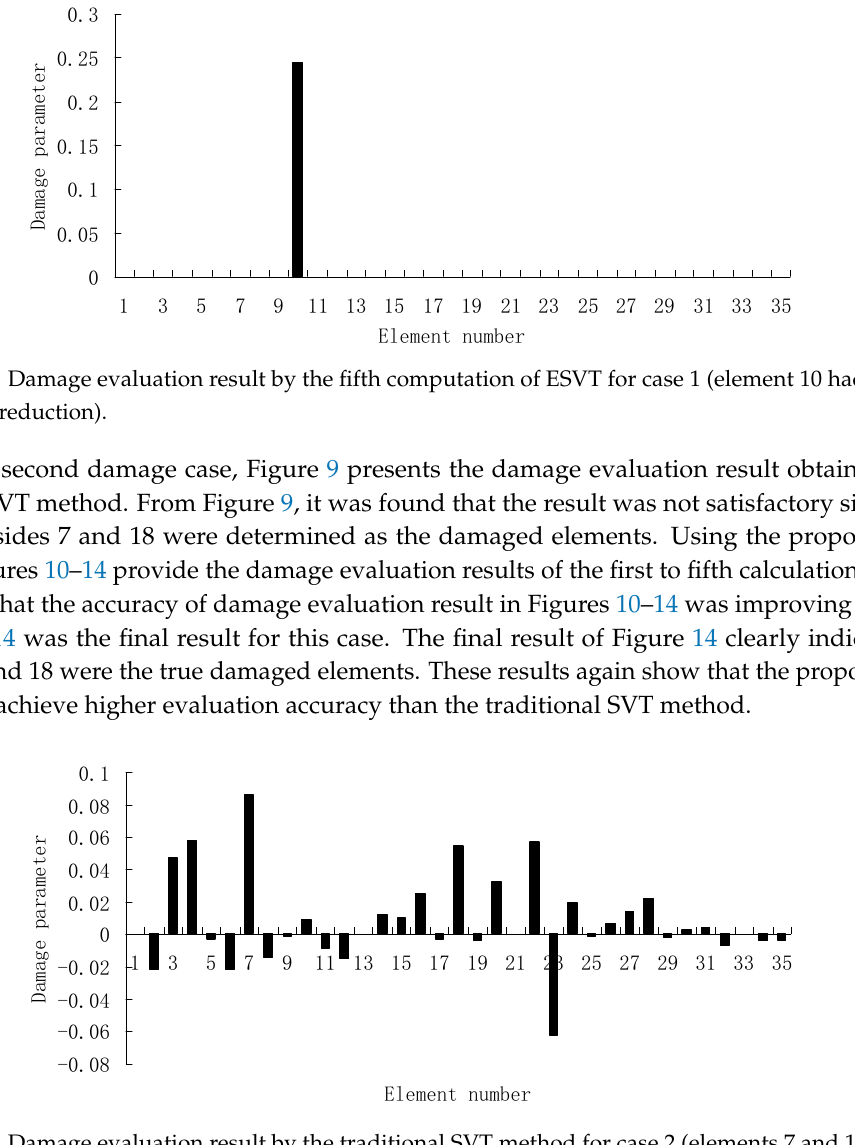
Figure 10. Damage evaluation result by the first computation of ESVT for case 2 (elements 7 and 18 had 15% and 20% stiffness reductions). -0.0500.050.10.150.2 1